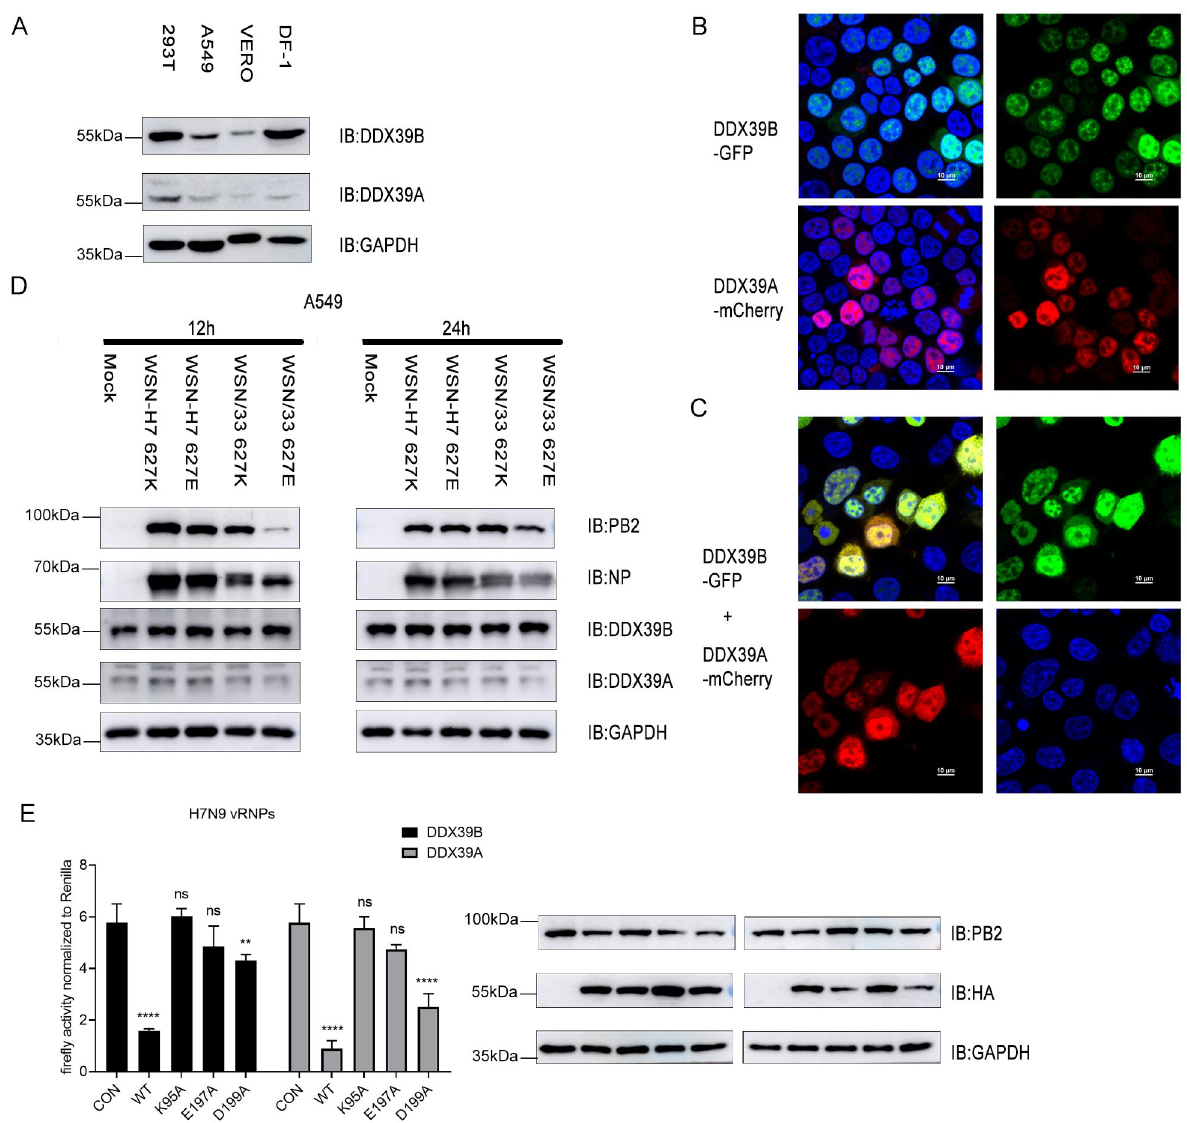
Fig 4. DDX39B and DDX39A inhibit polymerase activity depending on ATP binding and hydrolytic activity. (A) The protein levels of DDX39B and DDX39A in HEK293T, A549, Vero and DF-1 cells were measured by western blotting. (B) DDX39B-GFP or DDX39A-mCherry was transfected into HEK293T cells, 24 hours after transfection, the cells were then fixed, permeabilized. Cells were stained with the 4, 6-diamidino-2-phenylindole (DAPI) and were examined via fluorescence microscopy. (C) DDX39B-GFP and DDX39A-mCherry were co-transfected into HEK293T cells, 24 hours after transfection, the cells were treated the same as in (B). (D) A549 cells were infected with influenza virus WSN/1933 627K, WSN/1933 627E or recombinant influenza virus WSN-H7 (627K), WSN-H7 (627E) at MOI = 0.5. At 12h, 24h after infection, the cells were lysed and protein levels were measured by western blotting. (E) Polymerase genes (PB2 627 E), poll-Luc, RL-TK and corresponding HA-tagged mutants of DDX39B or DDX39A or empty pCAGGS vectors were co-transfected into HEK293T cells, 48h after transfection, the polymerase activity is detected. Statistical differences between groups are labeled according to two-way ANOVA. The results are presented as means ± standard deviations. �� , P < 0.01; ���� , P < 0.0001; ns, no significance. proteins tested (i.e., the M1 matrix protein, the M2 ion channel protein, and the NS2/NEP nuclear export protein) did not interact with DDX39B and DDX39A (S4B–S4D Fig) and their overexpression did not affect the DDX39A-mediated reduction of reporter protein expression from vRNPs in minireplicon assays (S4A Fig).